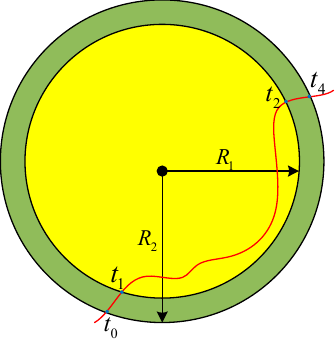
Figure 8. PIR Sensor Model.